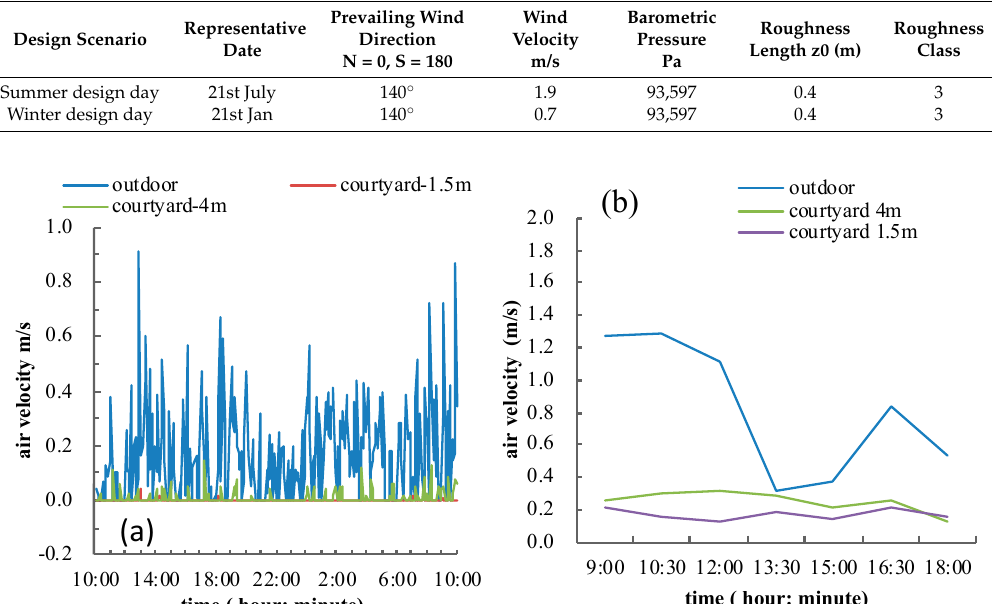
Figure 9. Wind speed in the courtyard and other spaces in: ( a ) summer and ( b ) winter.